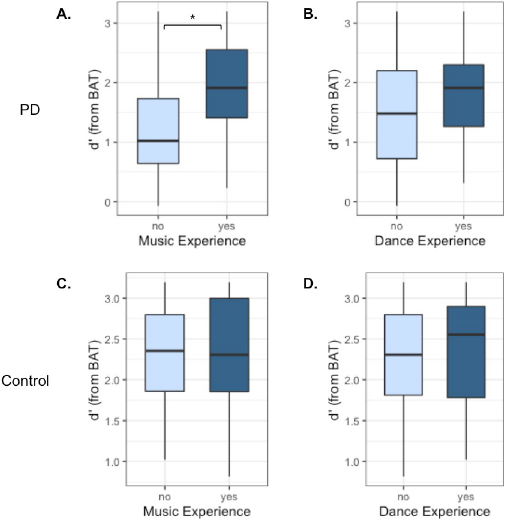
Fig 3. BAT results for PD participants with and without ME (A) and DE (B), and for the control group, again with and without ME (C) and DE